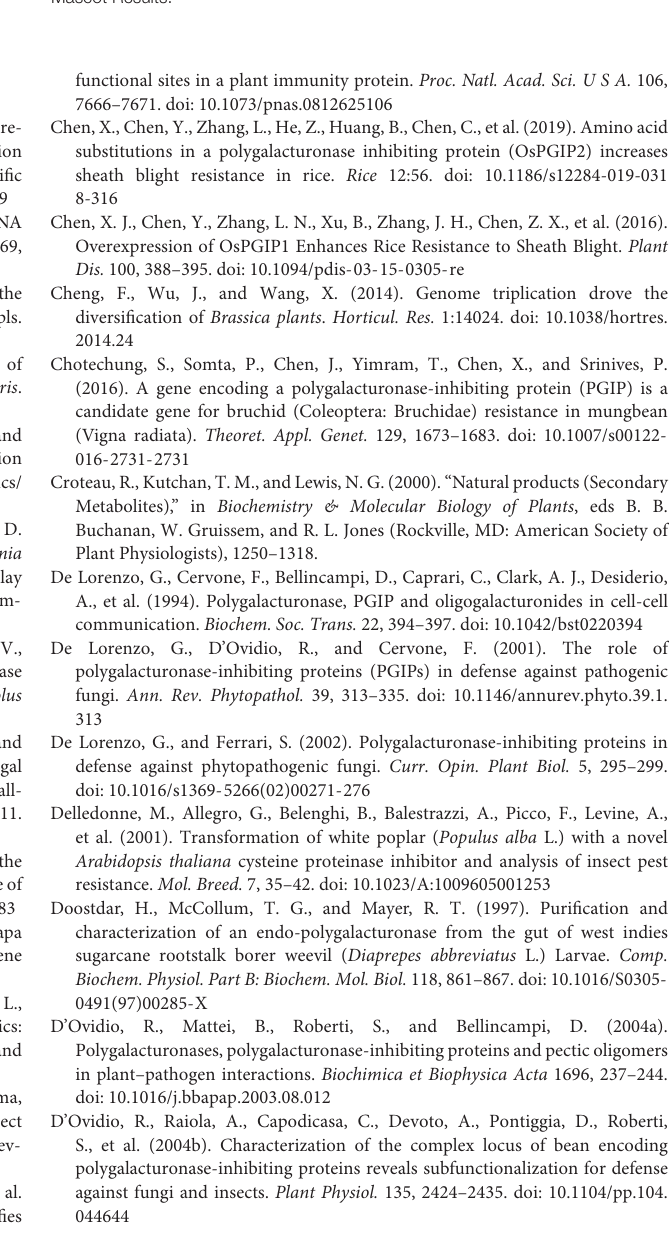
Supplementary Figure 2 | Alignment of PGIPs and PGIP-like proteins. Supplementary Figure 3 | Predicted functional classes from B. rapa ssp. pekinensis cell wall proteins (CWPs). Supplementary Figure 4 | Binding of P. cochleariae PG family members PCO_GH28-1 and -3 to pectic substrates. Supplementary Figure 5 | SDS-PAGE of pull-down assay of B. rapa ssp. pekinensis CWPs with an empty column (negative control). Supplementary Figure 6 | Alignment of BrPGIPs and BrPGIP-like proteins with homologs from different B. rapa ssp. pekinensis cultivars and Brassica species. Supplementary Figure 7 | Expression of BrPGIPs and BrPGIP-like genes in untreated B. rapa ssp. pekinensis . Supplementary Figure 8 | Interaction assay of PCO_GH28-1, -2, -4, -5, -6, -8, -9 with BrPGIP-like1-containing culture medium.